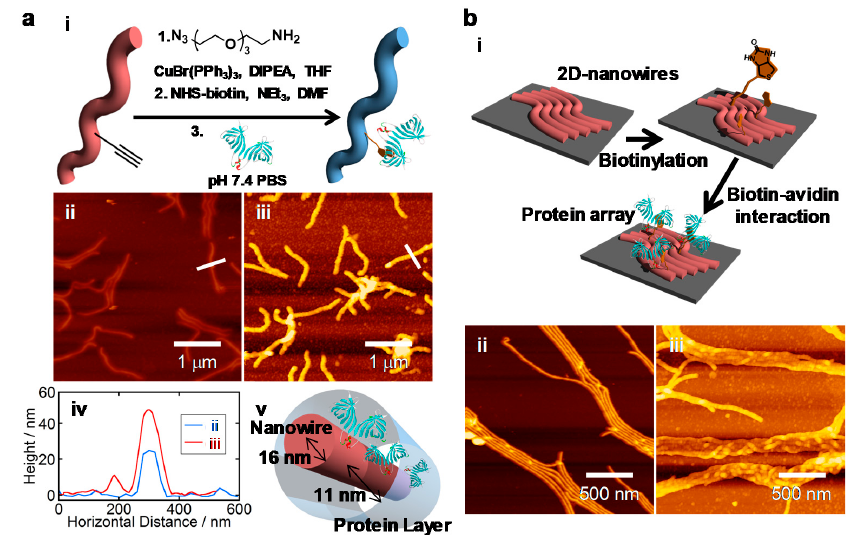
Figure 8. ( a-i ) Scheme for fabrication of the protein nanowires by using chemical modification and the avidin–biotin system. ( a-ii ) AFM micrograph of nanowires based on a PSES film prepared by exposure to 490 MeV 192 Os 30 + particles at 1.0 × 10 8 ions cm − 2 . ( a-iii ) AFM micrograph of modified